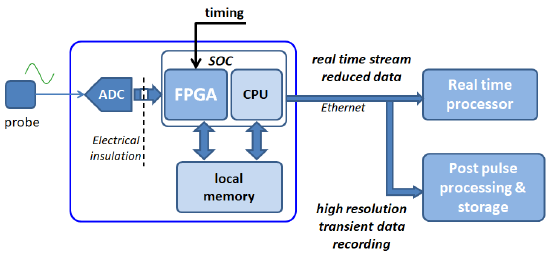
Figure 24. Block scheme of the new DAQ architecture for RFX-mod2, based on a System On Chip SOM. The DAQ board performs all necessary function by